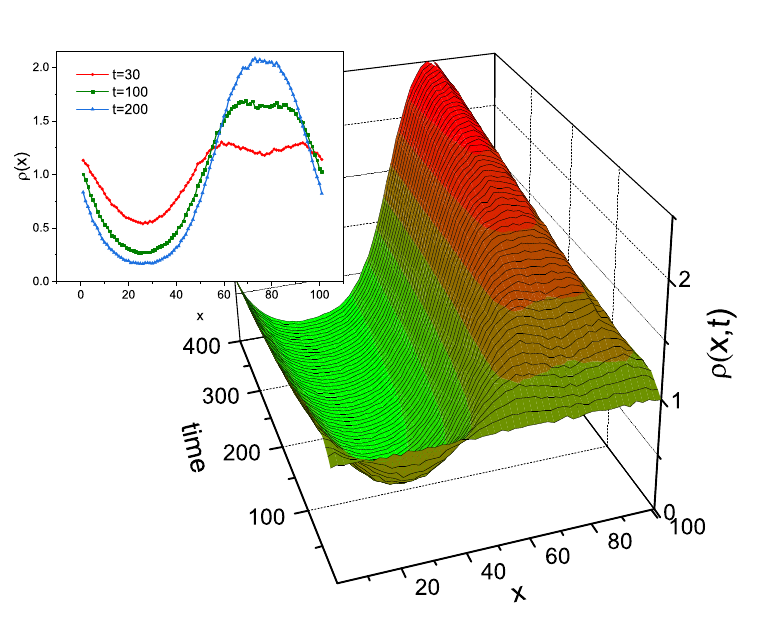
Figure 30. Plot of density ρ ( x , t ) of walkers in CTRW model. α =